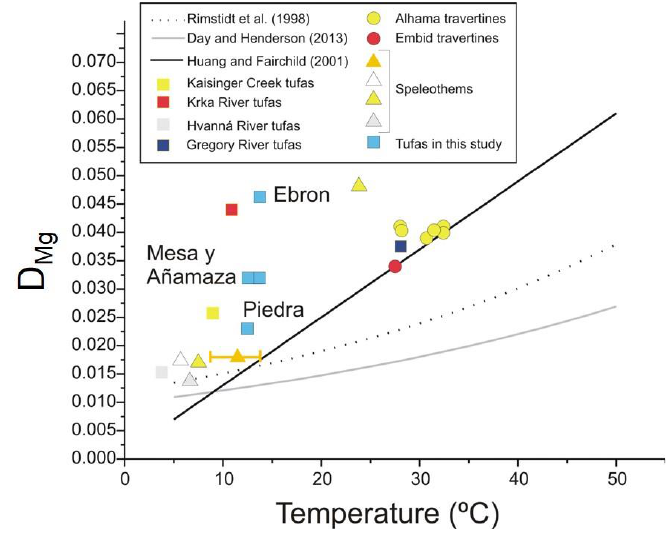
Figure 7. Mean D Mg and water temperature values obtained for tufa deposits in studied rivers compared with available data for other tufa-depositing rivers and streams, for thermal spring deposits (travertines) and some cave speleothems. We present experimental relationships between water temperature and magnesium partition coefficient (D Mg ) determined by the authors of [45,46] under karst/speleothem-analogue conditions, as well as exponential best-fit curve to the data in [58], obtained by the authors of [46]. Data for the tufa deposits. Mean D Mg and temperature values for Kainsinger Creek (Germany) were calculated from the data in [8] for sections T1, T2 and T3. Values for Krka River (Slovenia) were obtained from data presented in [6] at sampling points T1 – T10 (see Table S3 in [6]) and excluding highest D Mg values obtained at T11 – T13 sampling points with the greatest dolomite contents. Values for Gregory River (Australia) obtained from data presented in [1] for tufa deposits at one sampling point: mean D Mg value is that obtained in the review in [8], and mean water temperature value corresponds to the mean measured value (27.7 °C) for the studied period in [1]. Finally, the data for the calcite precipitated in Hvanná River (in the vicinity of the Eyjafjallajökull volcano, Iceland) were obtained from the range of D Mg values presented in [65] and the measured temperatures at Sites 2 – 9 (see Tables 1 and 3 in [65]). Data for the travertine deposits. These data correspond to deposits sampled at the Alhama thermal spring system and at the Embid thermal spring (both in Zaragoza, Spain), presented in [66]. We only plotted samples consisting of pure calcite and precipitating near the orifices of the springs and from natural waters (e.g., not overheated) in the figure. We obtained the D Mg values from the specific Mg/Ca values analysed in each deposit and the associated spring (water sample). Data for speleothems. Orange-filled triangle: mean D Mg (0.0178 ± 0.0005) and cave temperature values presented in [68] from recent carbonate crystals precipitated on watch glasses and glass plates in seven caves in Germany, Morocco and Romania; we also indicate a range of cave temperatures. Empty triangle: mean D Mg and drip water temperature presented in [9] for annually laminated stalagmites in Alpine cave (Obir, Austria). Yellow-filled triangles: mean D Mg and temperature values for seepage waters and associated calcites in speleothems from caves on Vancouver Island and in Jamaica studied in [67]. Grey-filled triangle: mean D Mg values and cave air temperature (assumed to be constant) presented in [45] for modern speleothems in Grotta di Ernesto cave (Italy).